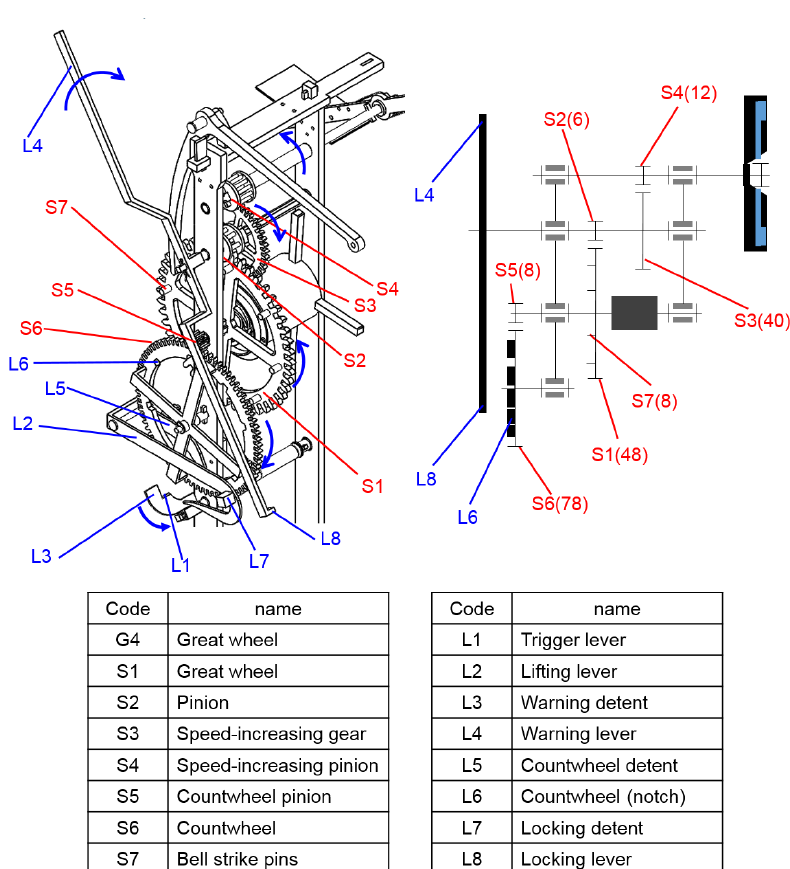
Figure 3. Striking train structure of the Cotehele clock